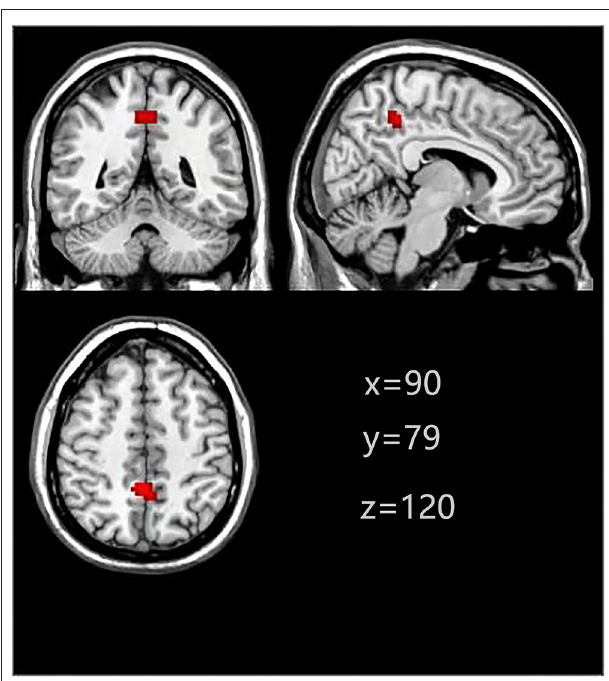
FIGURE 1 | Ventral attentional network (based on group-ICA with a threshold at z ≥ 5).